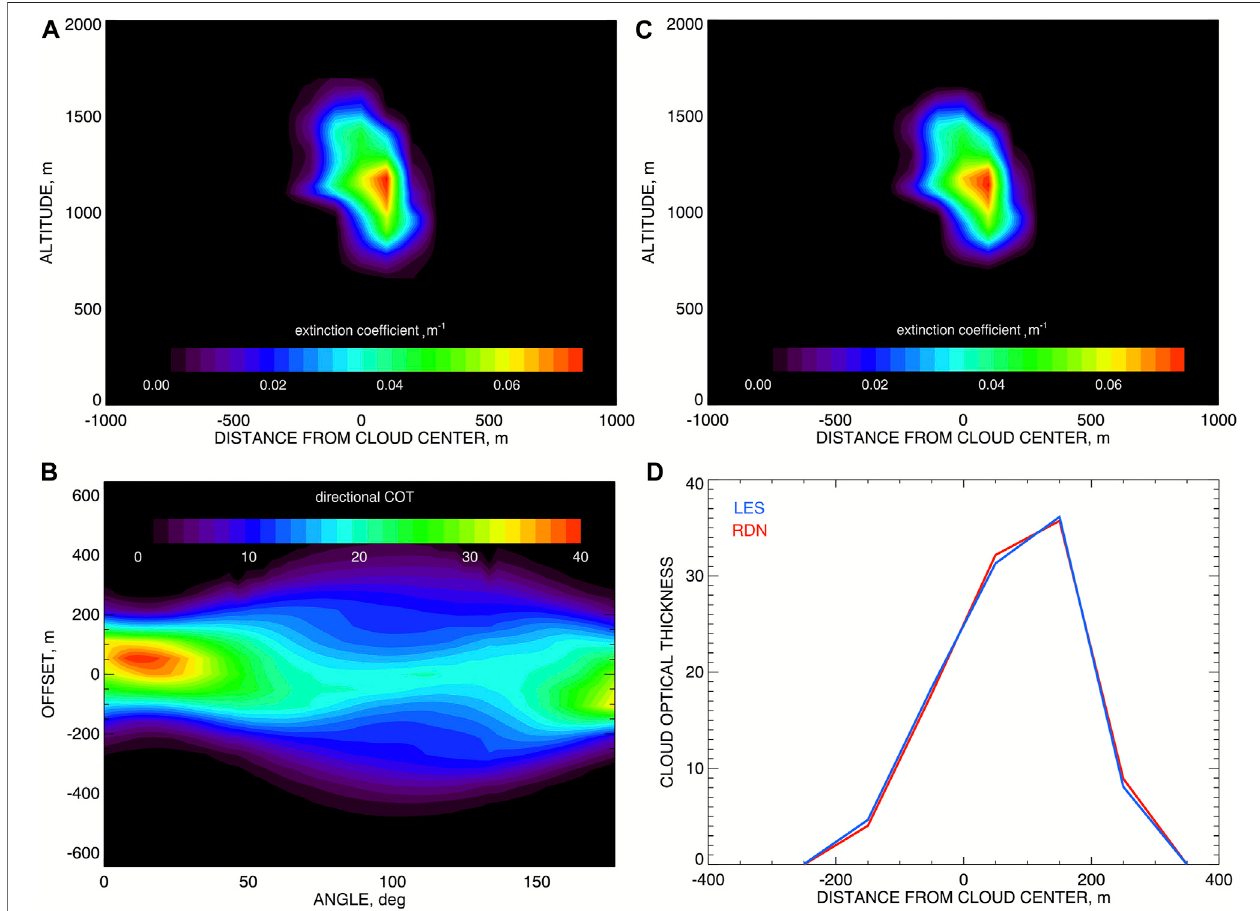
FIGURE 4 | Test of Radon transform on a LES-generated cloud. (A) The initial 2D cross section of the cloud ’ s extinction coef fi cient distribution; (B) The directional COT tomogram derived from the fi eld at (A) using direct Radon transform; (C) The result of inverse Radon transform applied to the tomogram at (B) (after calibration using the COT computed from the initial fi eld); (D) The initial COT (blue) and that computed from the extinction fi eld (from (C) ) after calibration (red).